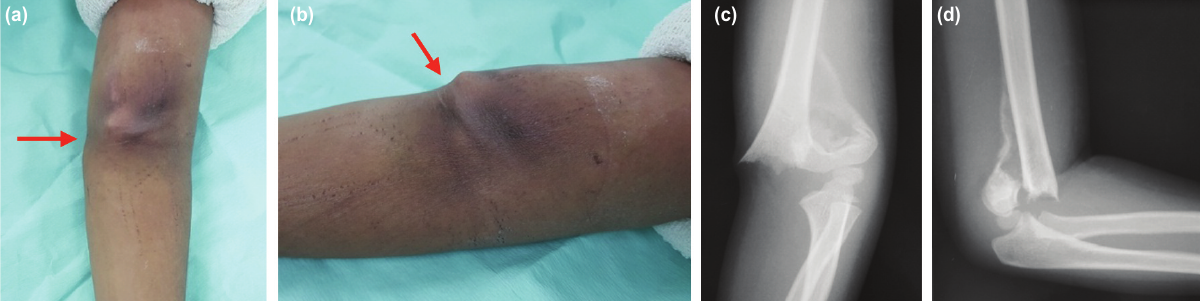
(a, b) shows the metaphyseal spike (red arrow) obtruding the skin at the medial aspect of the antecubital fossa. Brachial and Fig. 1: radial pulses are not palpable clinically, and there is no signal detected on hand-held Doppler examination. (c, d) Plain radiographs of the affected left elbow reveal a Gartland III supracondylar humeral fracture with callus formation at the posterior aspect of the proximal fracture fragment.